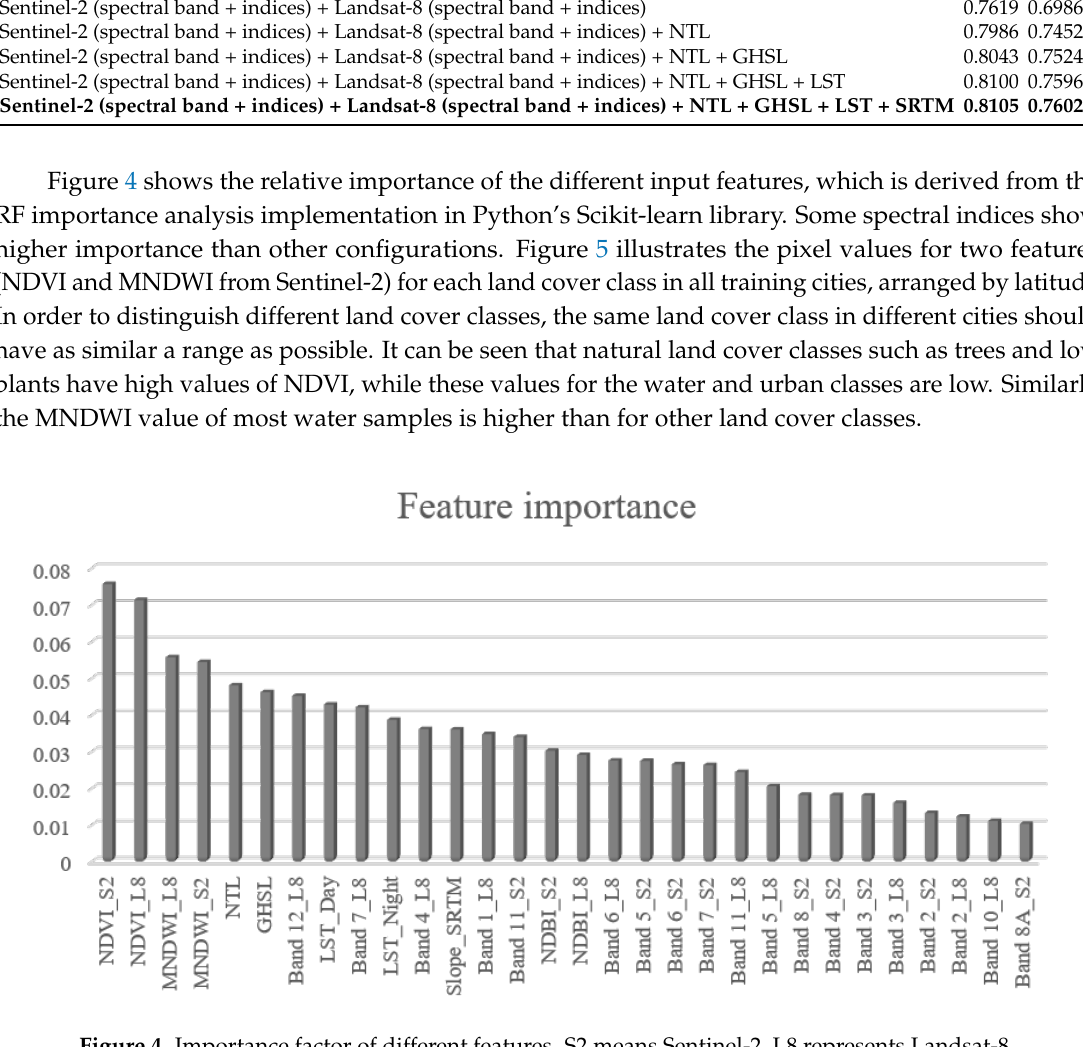
Figure 4. Importance factor of different features. S2 means Sentinel-2, L8 represents